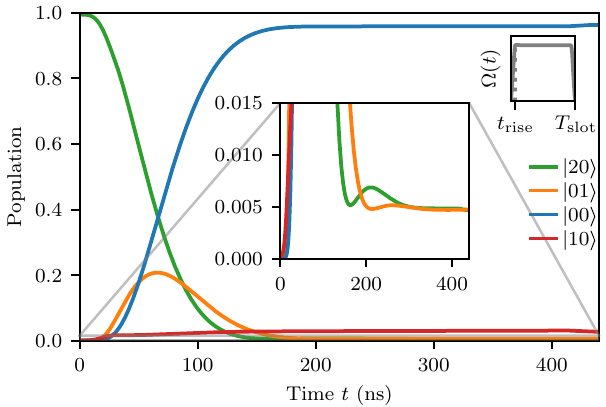
FIG. 7. Time evolution from the initial state | 2 (cid:2)(cid:10) 2 | ⊗ σ th for t rise = 30 ns and for an otherwise always-on drive during T slot . This is simulated with the same (cid:6)/ 2 π ≈ 204 MHz and ω d / 2 π ≈ 5.2464 GHz as at the operating point in Fig.